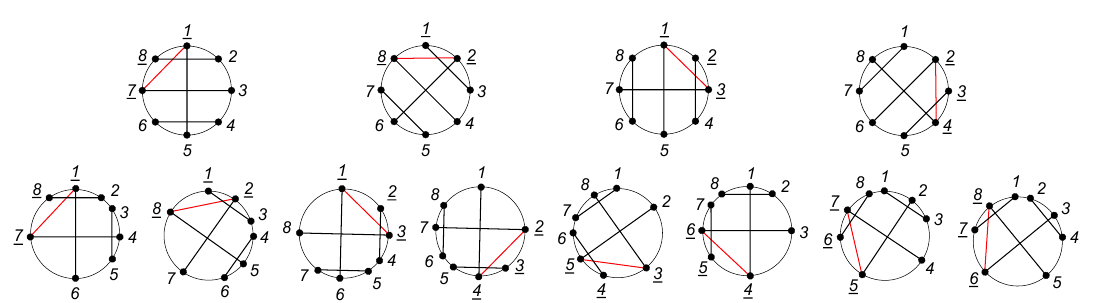
Figure 9 . Six-point φ 4 Witten diagram.